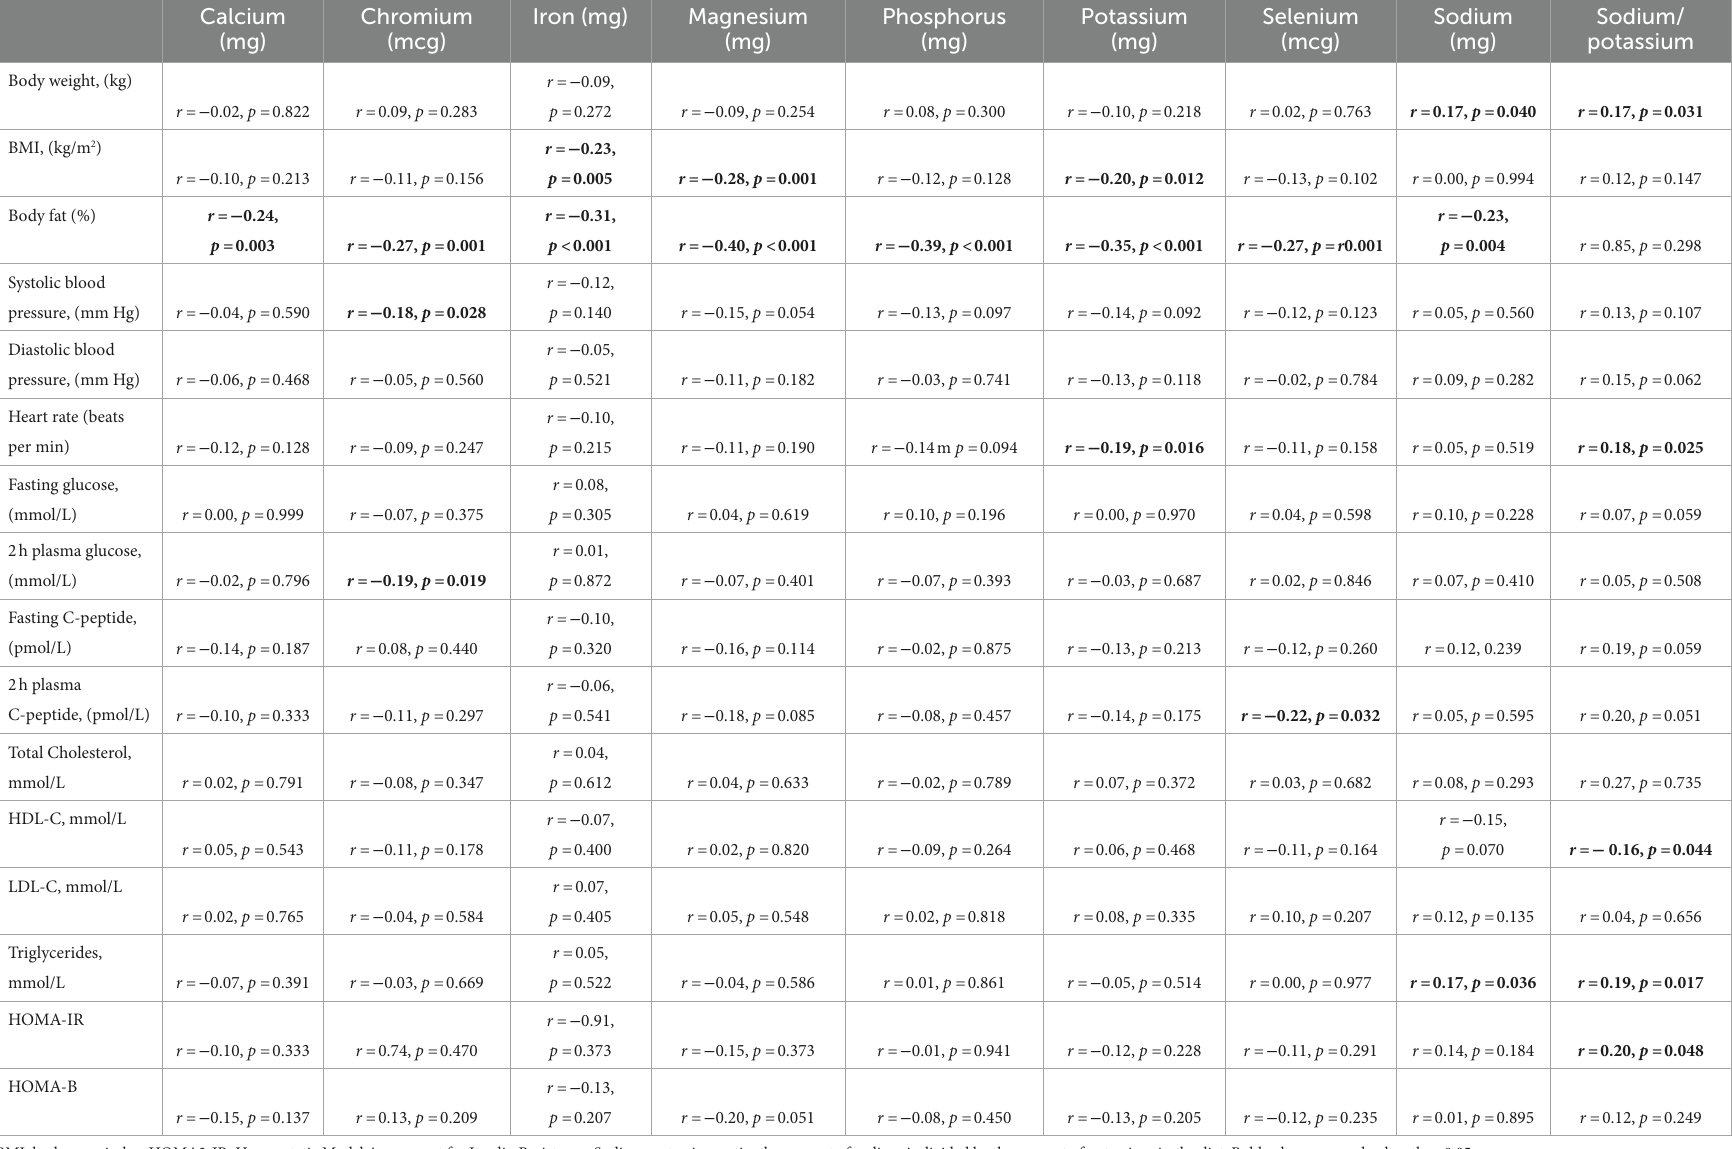
TABLE 3 Spearmen correlations between minerals and metabolic